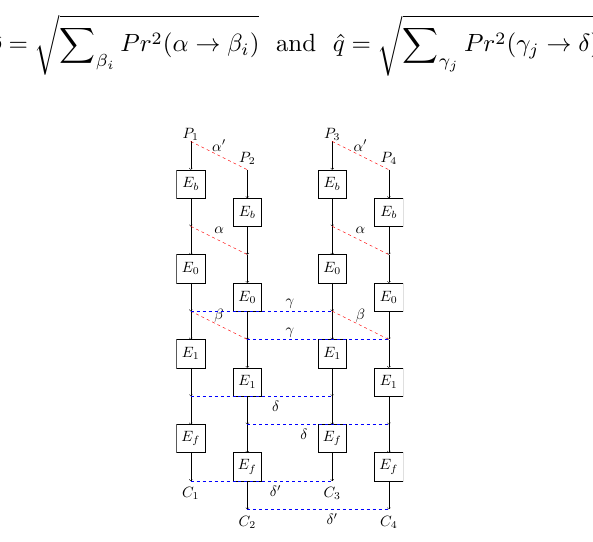
Figure 2: Rectangle attack on block cipher E